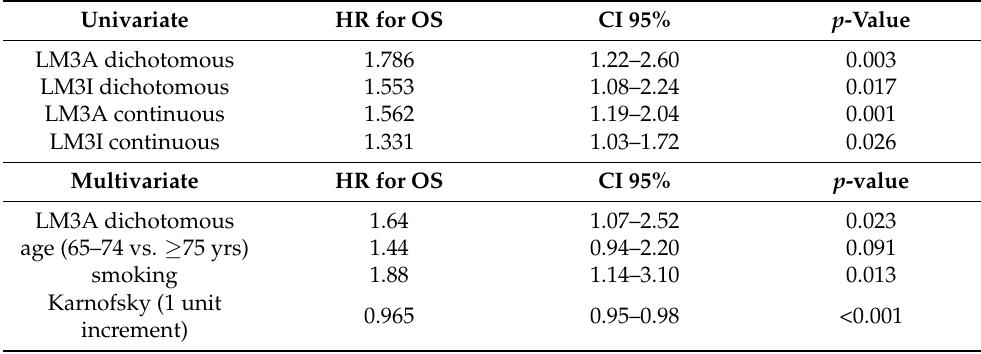
Table 3. Univariate Cox regression models of sarcopenia parameters for overall survival. Dichoto- mous classifications compare non-sarcopenic patients (i.e., high values, i.e., >cut-off) vs. sarcopenic patients (i.e., low values, i.e., ≤ cut-off). HR and CI values of the continuous variables have been inverted to facilitate comparability with the dichotomous classification. The strongest skeletal muscle index “L3MA dichotomous” was included in a multivariate regression model with known factors of deteriorated overall survival. L3MA, calculated cross-sectional skeletal muscle area at the third lumbar vertebra; L3MI, calculated skeletal muscle index at the third lumbar vertebra; HR = hazard ratio, OS = overall survival, CI = confidence interval. Univariate HR for OS CI 95% p